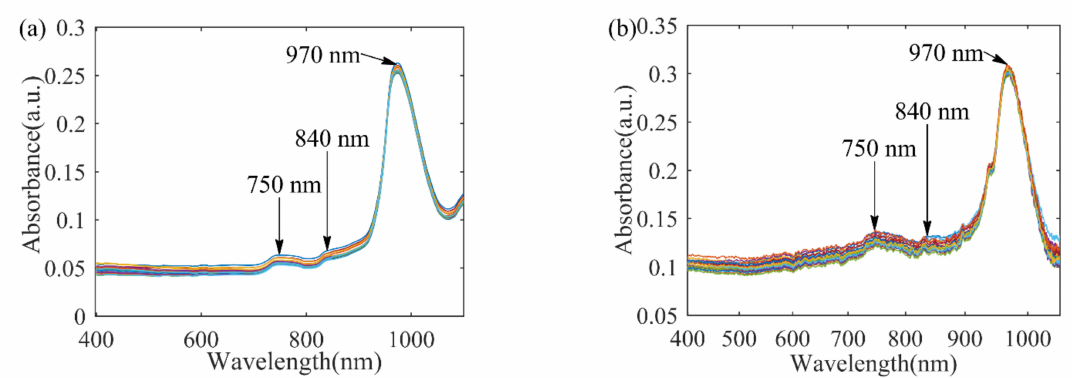
Figure 1. Original Vis-NIR spectra of distilled water samples: ( a ) spectrophotometer experiment; ( b ) grating spectrograph